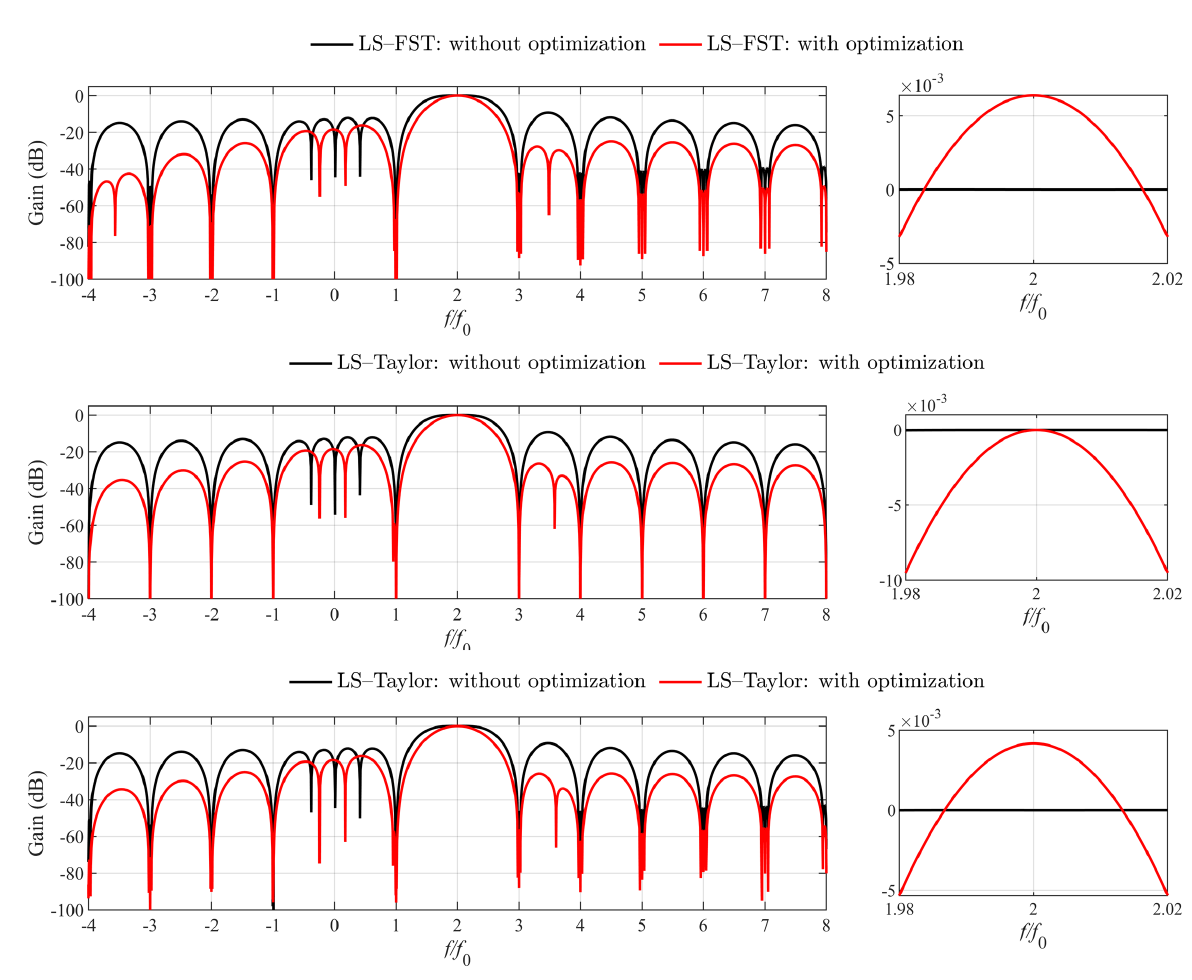
Figure 3. The frequency responses of second harmonic phasor filters for the three least-square algorithms with and without using the proposed optimization. Similar frequency responses can be observed in other order harmonic